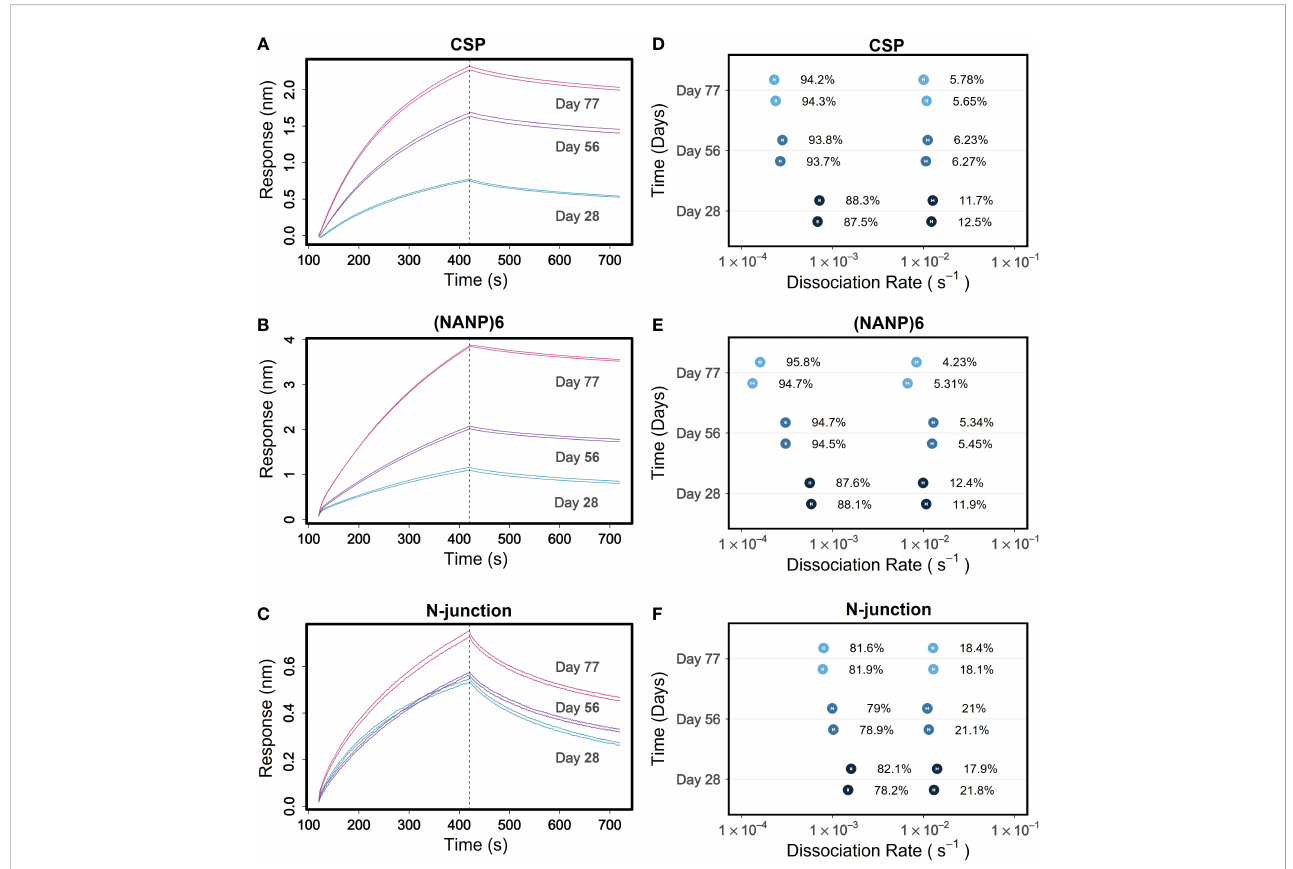
FIGURE 7 Tracking of fi ne-resolved af fi nity maturation of antibody responses to different CSP antigens elicited in a protected RTS,S/AS01 malaria vaccinee. (A – C) Time-courses of 1:50 diluted sera from days 28, 56 and 77 corresponding to post-immune 1, 2 and 3 time points respectively of a protected RTS,S/AS01 vaccinee are shown for binding to antigens recombinant CSP (A) , NANP6 peptide (B) and N-interface peptide (C) in duplicate. (D – F) Different k d values dissected for each replicate at days 28, 56 and 77 are shown for binding to CSP (D) , NANP6 (E) and N-interface (F) . In panels (D – F) , the error bars associated with symbols indicate the standard error in the estimate of k d